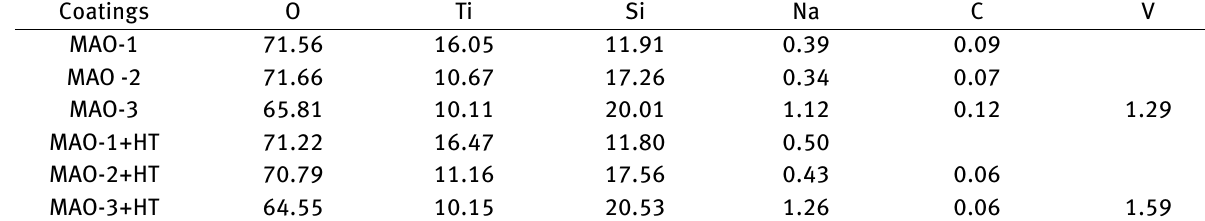
Table 1: EDS results of MAO coatings prepared on Ti substrates before and after heat treatment